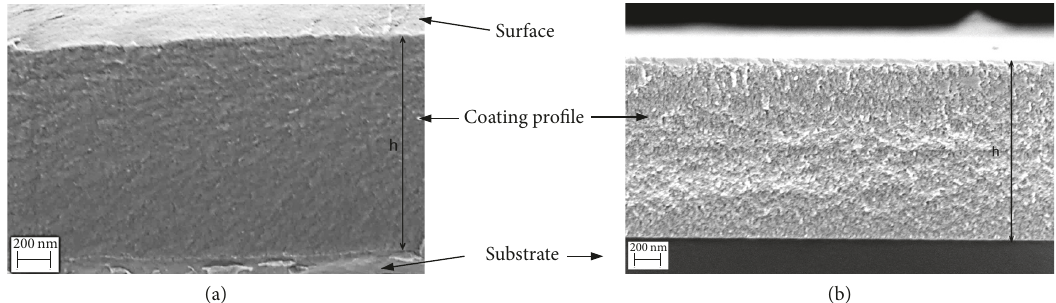
Figure 11: Cross-sectional SEM images of AlTiN coatings deposited at 500 Hz on 100Cr6-steel substrate (a) and silicon substrate (b) with film thickness ℎ = 1.437 𝜇 m.